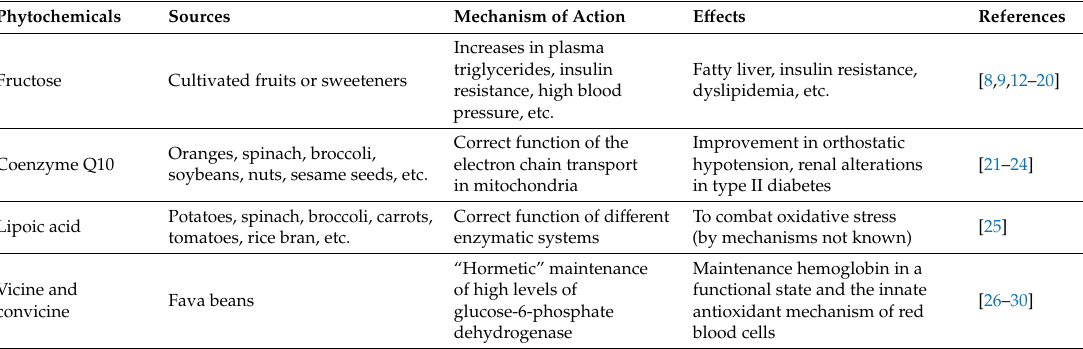
Table 1. Sources, mechanism of action and e ff ects of dietary